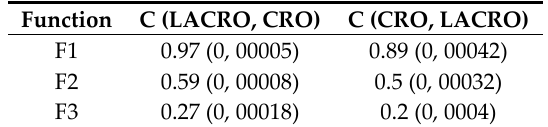
Table 3. Average value of C-metric based on 10 independent